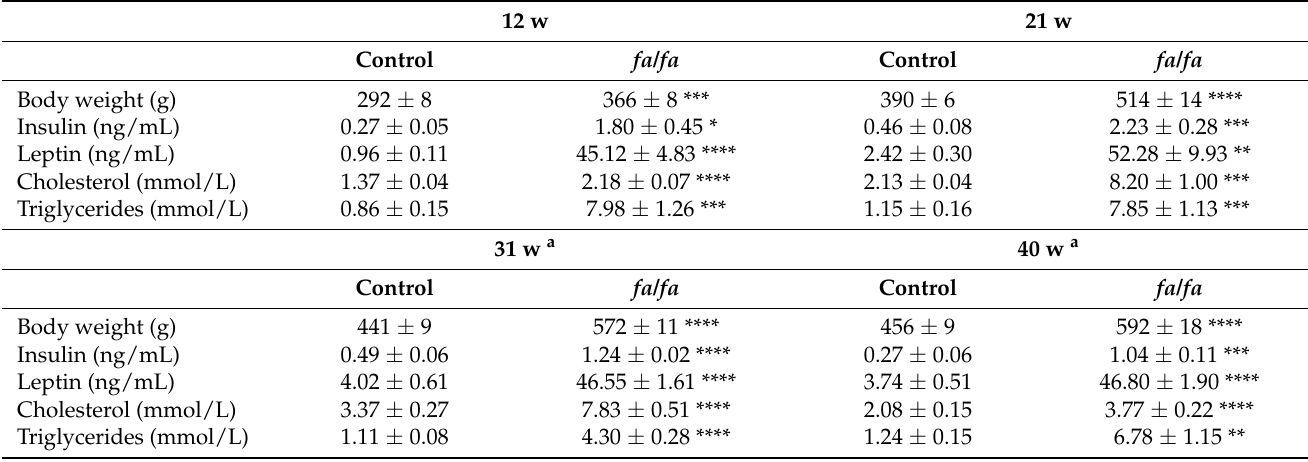
Table 1. Body weight and selected metabolic parameters in fasted blood plasma of fa / fa and control rats at 12, 21, 32, and 40 weeks of